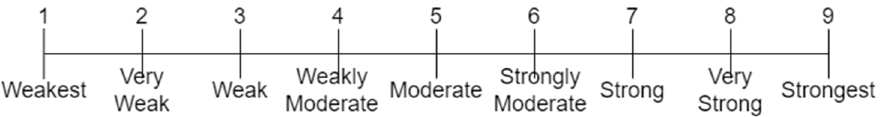
Figure 9. Graphic representation of the 9 ‐ values scale and its crisp weights.